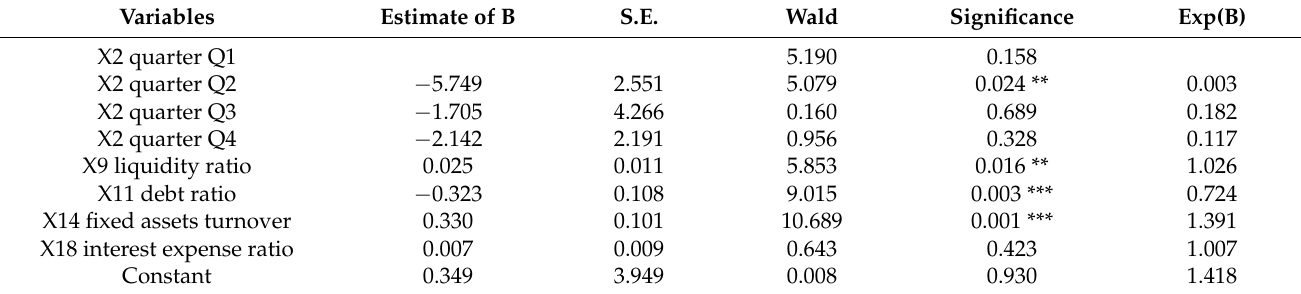
Table 15. Significance values of feature selection variables of 491 normal and 491 bankrupt companies (1:1) in LR. Variables